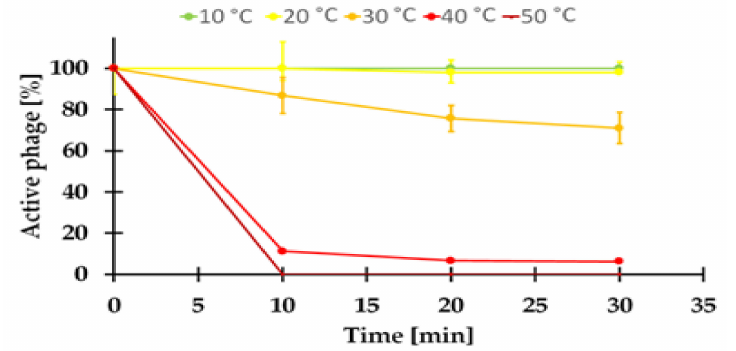
Figure 5. Phage KASIA stability under various